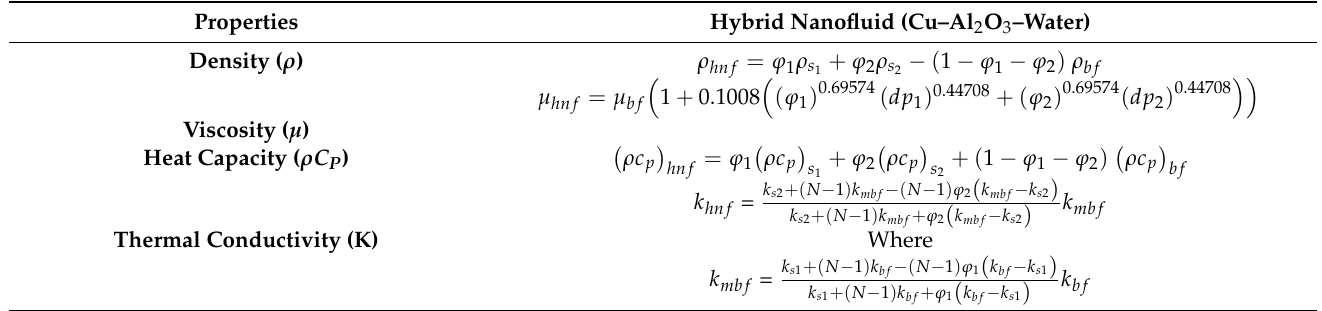
Table 1. Thermophysical properties of HN fd [41].